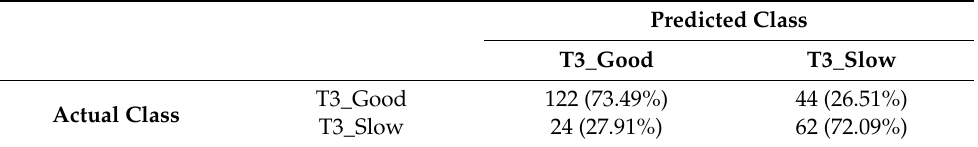
Table 4. Classification table in CART analysis for T3 stabilization time.